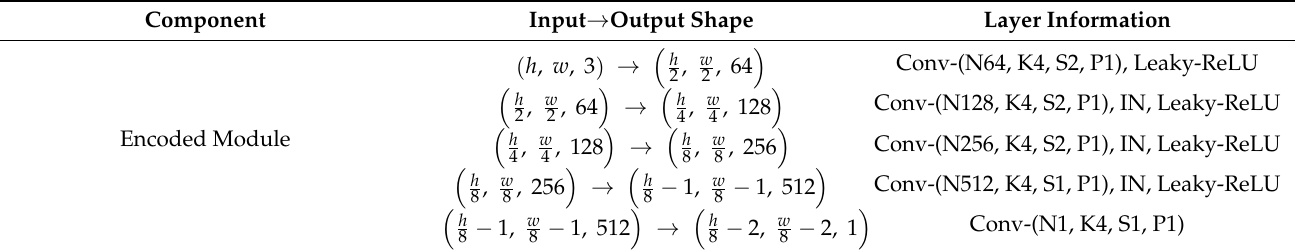
Table 2. Discriminator network